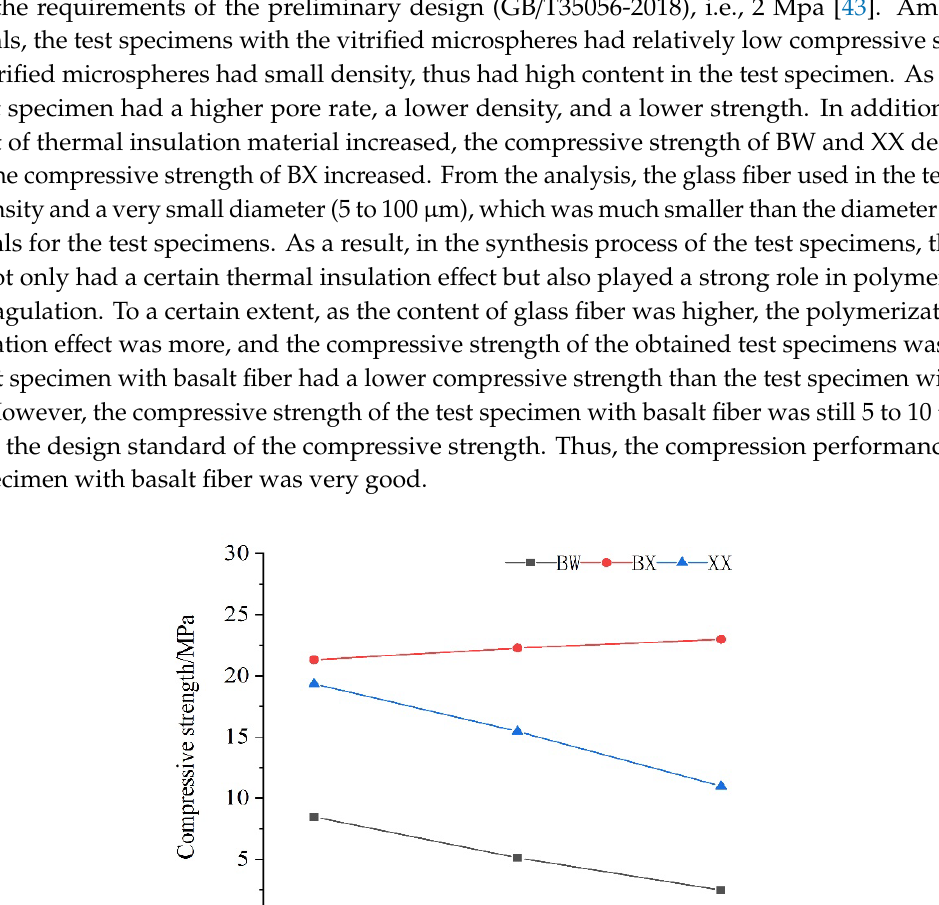
Table 14. Material performance parameter comparison table.